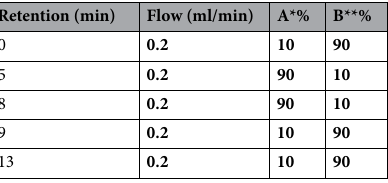
Table 1. HPLC procedure for sample peak separation. *Acetonitrile + 0.1% Tri-fluolroacetic acid; **Water + 0.1% Tri-fluolroacetic